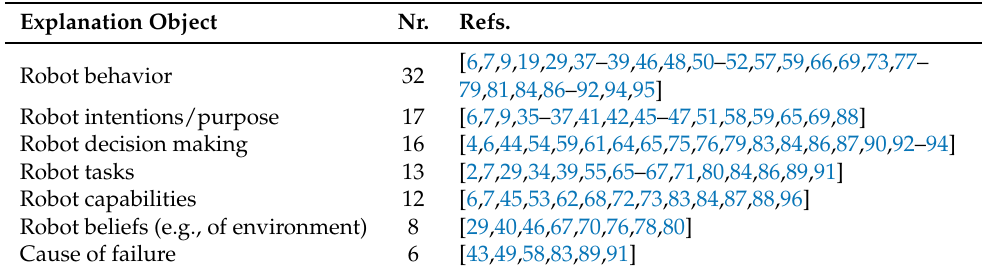
Table 4. Overview of the communicative purpose, i.e., the item of explanation that is aimed to be made